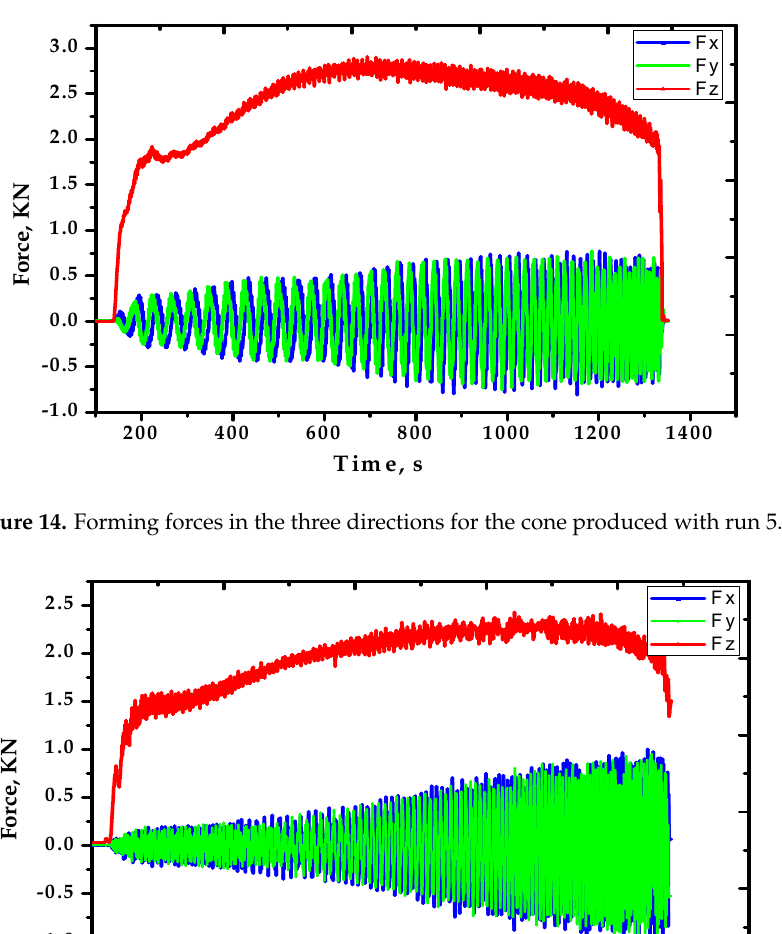
Figure 13. Forming forces in the three directions for the cone produced with run 4. Metals 2017 , 7 , 484